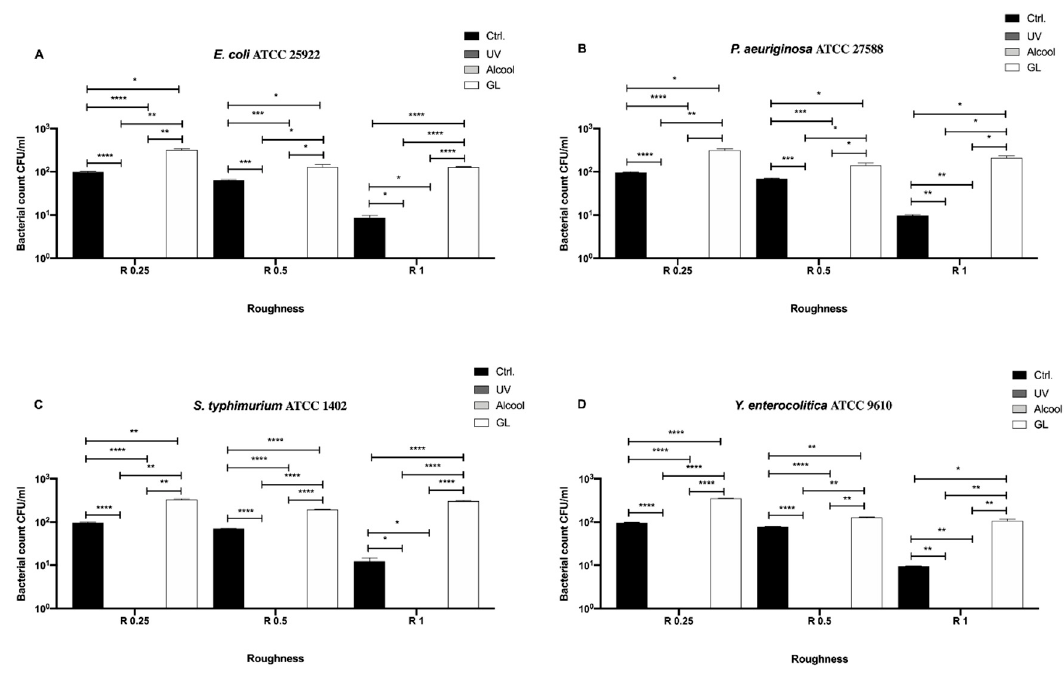
Figure 7. Antibacterial activity of UV, alcohol and GL against Gram-negative bacteria ( A ) E. coli ATCC 25922, ( B ) P. aeruginosa ATCC 27588, ( C ) S. typhimurium ATCC 1402 and ( D ) Y. enterocolitica ATCC 9610 at different surface roughness on DURALTI ® ‐ treated disks, **** p < 0.0001, *** p < 0.001, ** p < 0.01, * p < 0.05.